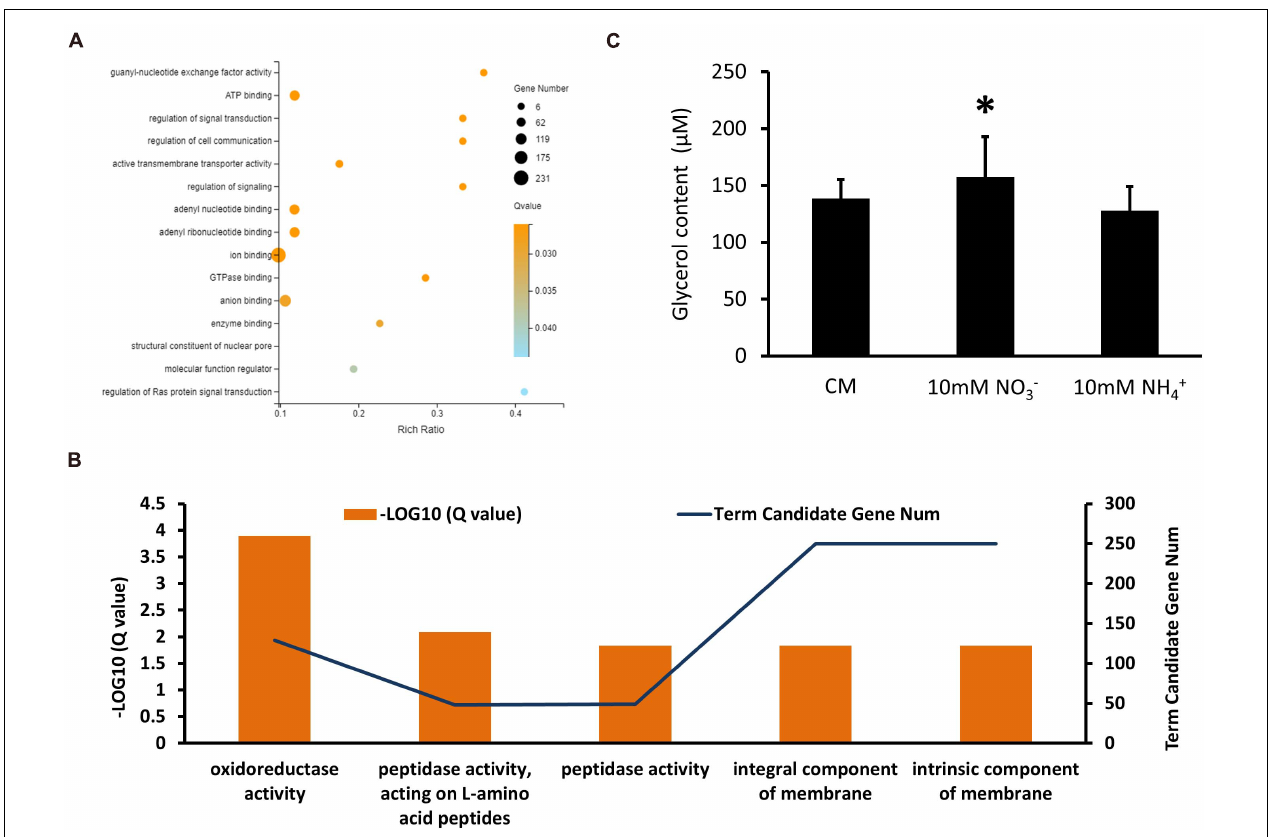
FIGURE 9 | Enrichment analyses of differentially expressed genes (DEGs) in Verticillium dahliae in response to ammonium sources. (A) A bubble chart showing DEGs upregulated during ammonium utilization and enriched in 13 GO terms. The size of the bubbles is proportional to the total number of DEGs. The X -axis indicates enrichment ratio and the Y -axis indicates the GO terms. (B) A linear graph showing DEGs downregulated in ammonium utilization and enriched in five GO terms. (C) The bar chart showed glycerol content of the XS11 strain treated with 10 mM NO 3 − or 10 mM NH 4 + for 24 h. Error bars represent the standard deviation based on three independent replicates. Asterisks indicate significant differences ( ∗ P <